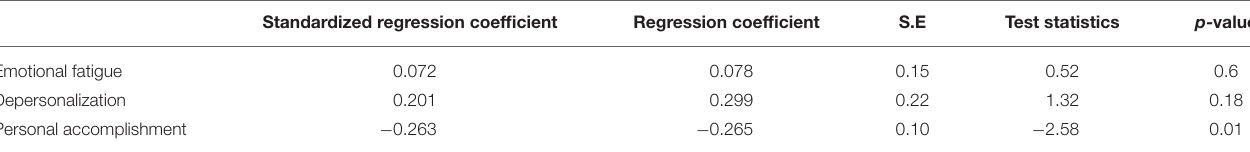
TABLE 3 | Regression coefficients related to the association between burnout dimensions and turnover intention.